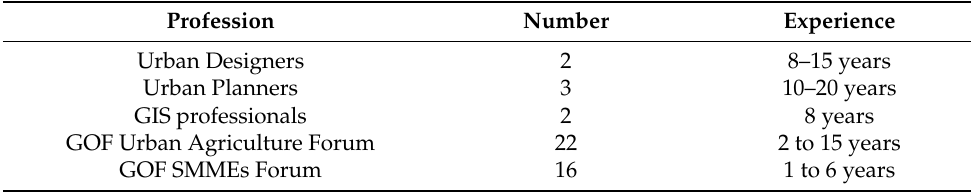
Table 2. Profile of workshop